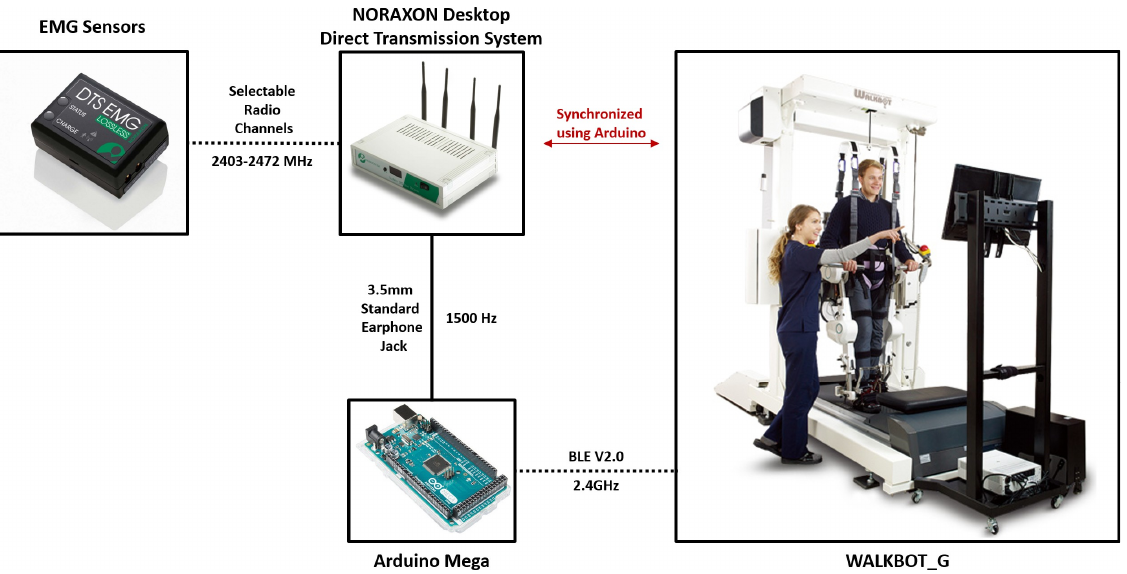
Figure 1. Schematic system configuration for synchronization between TeleMyoDTS and WALKBOT_G.